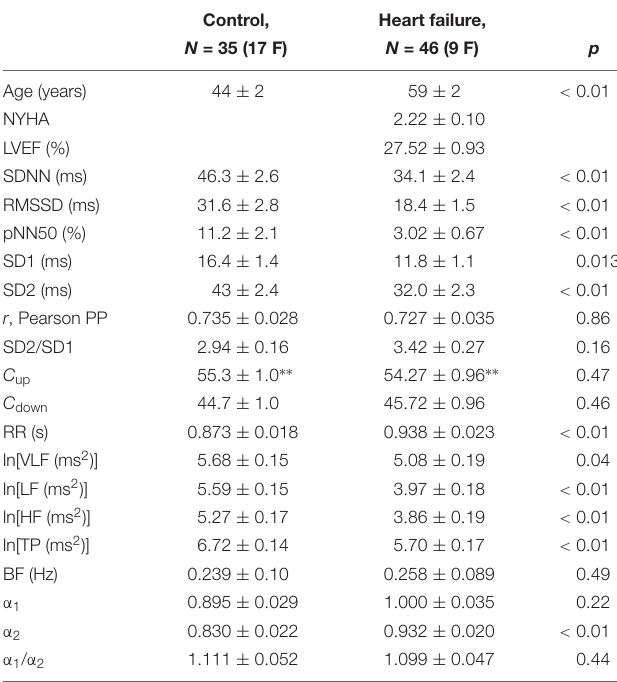
TABLE 1 | Anthropometric data, clinical parameters, and linear and non-linear parameters of heart interbeat intervals in healthy control subjects and heart failure